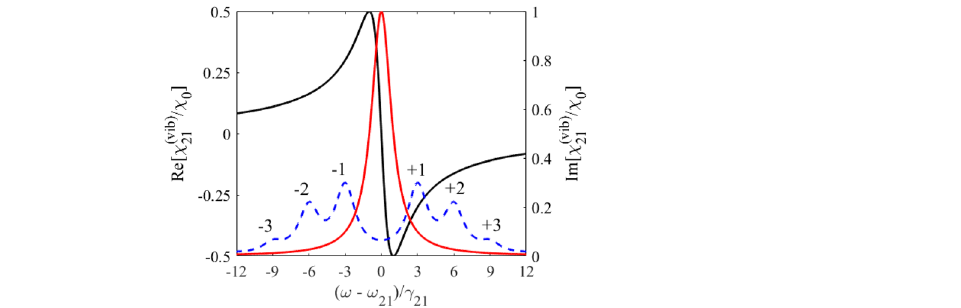
Figure 8. In the vibrating reference frame, real (black curve, left axis) and imaginary (red curve, right axis) parts of the resonant susceptibility Eq. (23) of the motionless absorber as well as the spectral density of the ω 21 , spectrally broadened, γ S γ 21 , incident wave packet with Lorentz spectral profile, Eq. (45), resonant, ω 0 = = 3 and p 2.4 γ 21 p 1 (blue dashed line) under � = = = (cid:31) (due to overlapped long wings of the Lorentz spectral contours) in the vibrating reference frame (Fig. 8), leads to the so-called dynamical beats in the waveform of the output photon waveform 25 (Fig. 7, green line). As a result, the distortions in the incident photon spectrum and waveform are so large that the concept of the pulse delay and pulse propagation velocity become inapplicable in this region. As shown in Fig. 6, the maximum propagation delay and the minimum propagation velocity of the Lorentzian γ 21 3 , as in the case of pulse occur at the minimum absorber vibration frequency, limited by relation (44), � = the Gaussian photon. However, unlike the Gaussian photon, in the case of the Lorentzian photon, there is also (cid:31) 6 , at which the propagation delay achieves the maximum value (Fig. 6a, green an optimal optical depth, T a ≈ circle), whereas the propagation delay of the Gaussian photon constantly increases with increasing optical depth (see Fig. 4a). The maximally delayed Lorentzian single-photon pulse at optimal values of (cid:31) and T a is shown in 0 corresponds to the peak of the Fig. 7 by the solid red line. It consists of two maxima. The first maximum at t = undelayed Sommerfeld–Brillouin precursor, and the second maximum corresponds to the delayed fraction of the output wave packet caused by steep nuclear dispersion inside the AIT spectral window in the formed nuclear response (see also Fig. 2, where the blue and red lines are the nuclear response, and the dashed black line is the incident field spectrum). The latter can be seen from a comparison of the red solid line in Fig. 7 with the dashed red line corresponding to the same photon passed through the same absorber at rest. In the motionless absorber, the incident photon is completely absorbed during 136 ns due to the rapidly developing collective response of nuclei (speed-up effect 51 ), which is characterized by strong absorption of the Lorentz-shape field resonant to the nuclear transition. The collective response of the oscillating nuclei to the stepwise front (long spectral wings) of the pulse is the same as for the motionless absorber, namely strong and fast, which corresponds to the same shape and duration of the Sommerfeld–Brillouin precursor and strong attenuation of the field. However, as soon as the